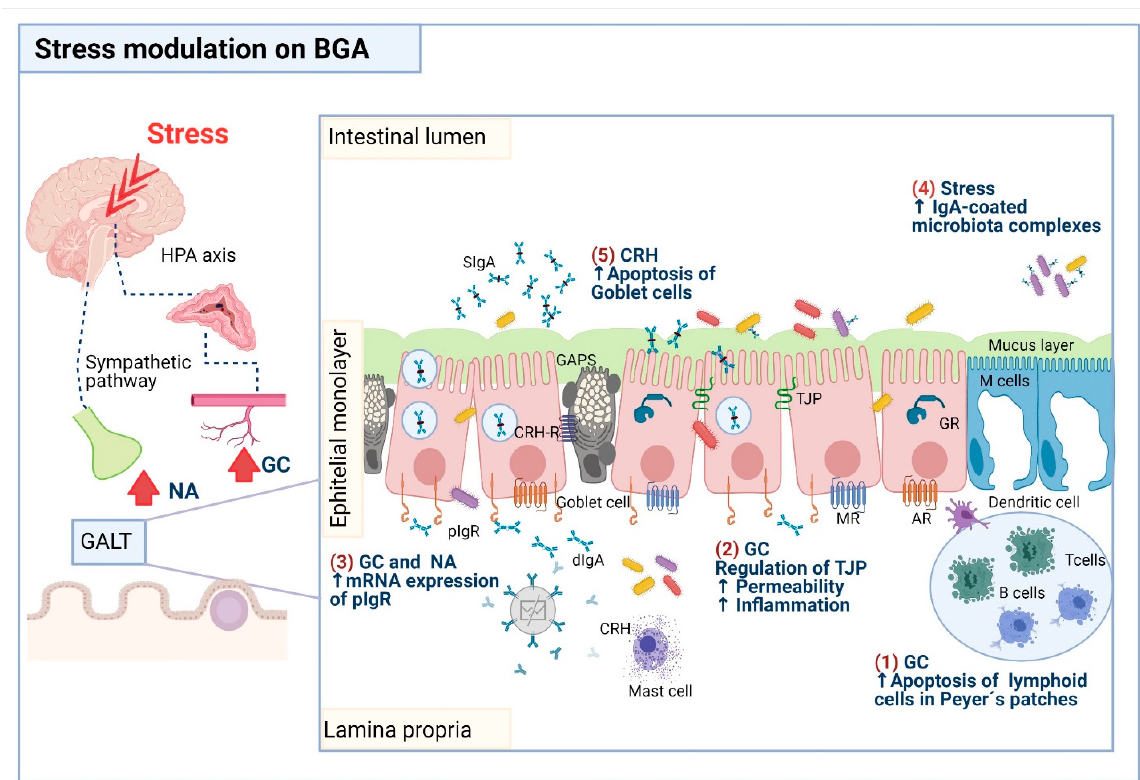
Figure 1. Proposed mechanisms that underlie the impact of stress on components of intestinal homeostasis, including IgA mucin and goblet cells. (1) Lymphoid cells present in Peyer’s patches are susceptible to apoptosis by the actions of glucocorticoids (GC), so the number of plasma cells producing IgA antibodies is decreased. (2) GC disrupt the expression of the tight junction proteins (TJP), resulting in increased intestinal permeability, and concomitantly, bacteria translocation toward the intestinal lamina propria, a phenomenon that can prompt an inflammatory process. (3) GC and noradrenaline (NA) increase pIgR expression promoting the IgA transcytosis and then the release of secretory IgA (SIgA) in the intestinal lumen. (4) Stress-induced IgA-microbiota complexes. (5) Corticotropin-releasing hormone (CRH) secreted by mast cells prompts goblet cell apoptosis and mucus depletion. Abbreviations: AR, adrenergic receptor; MR, muscarinic receptor; GR,